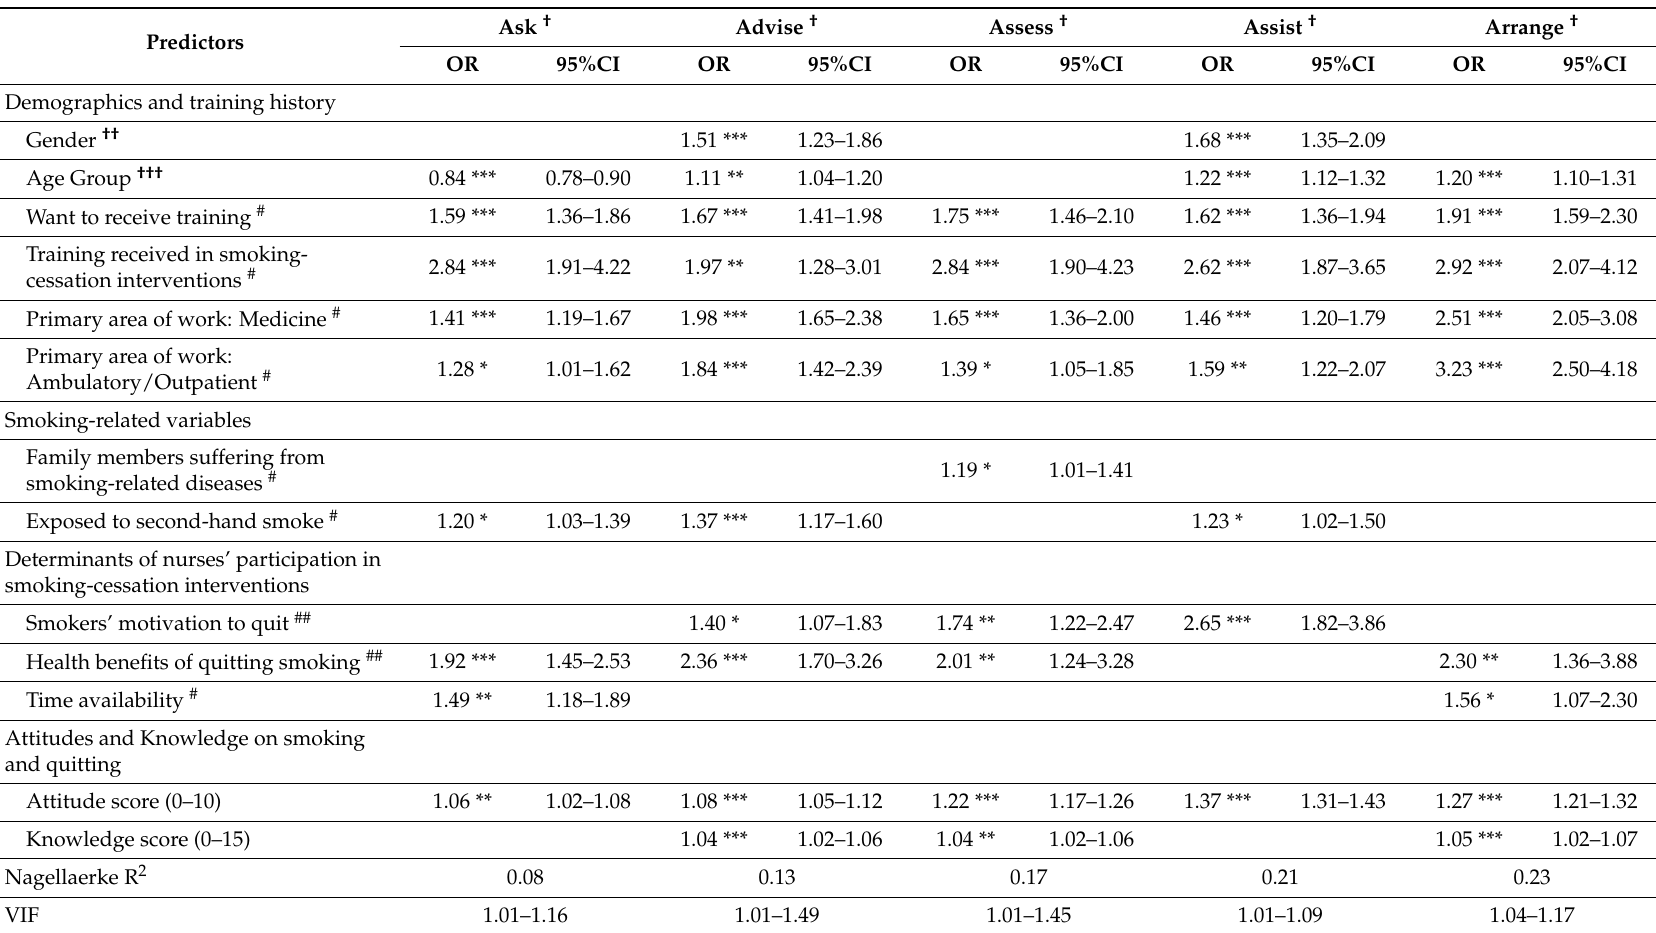
Table 8. Logistic regression model of the 5 A’s (N =